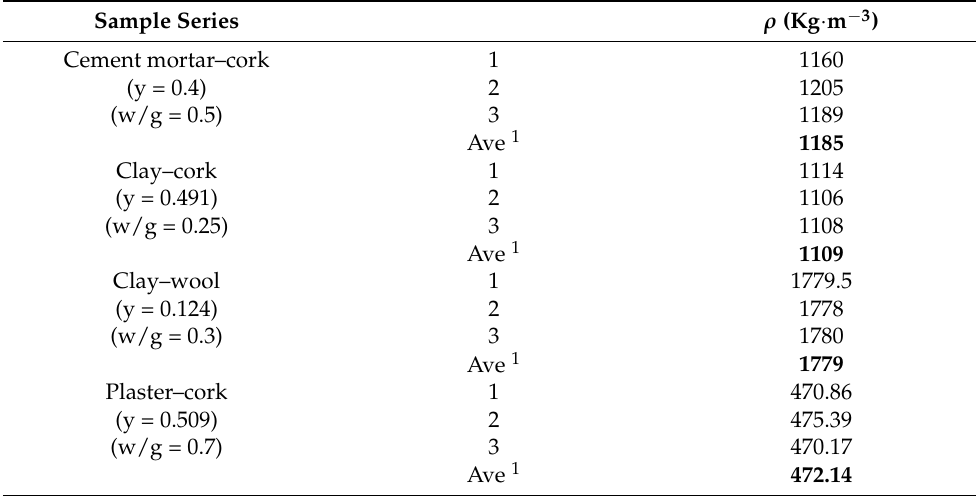
Table 3. Results of apparent density of the composites